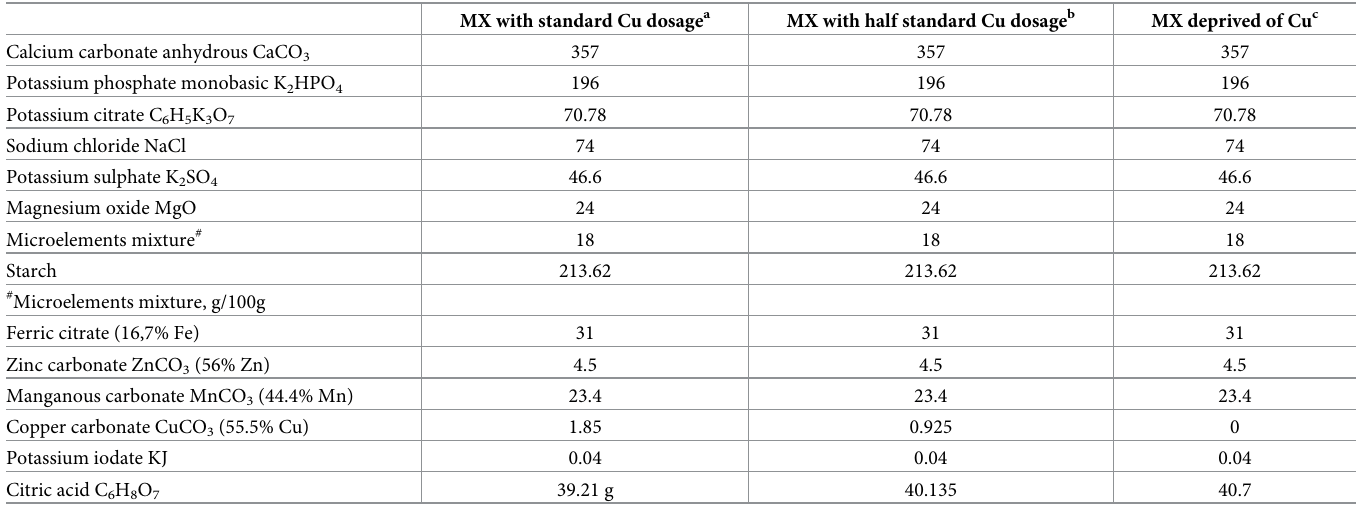
Table 3. Composition of mineral mixtures (MX) used in experimental diets, g/kg. MX with standard Cu dosage